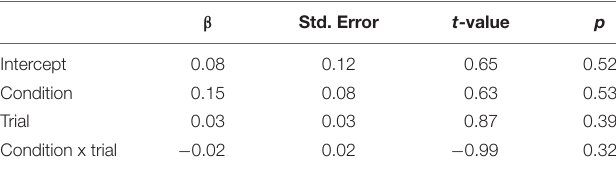
TABLE 2 | Fixed effects of condition, trial, and condition × trial on pupil